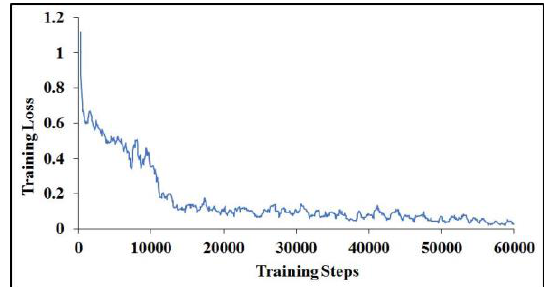
Figure 8. Training loss curve drew by Tensorboard.